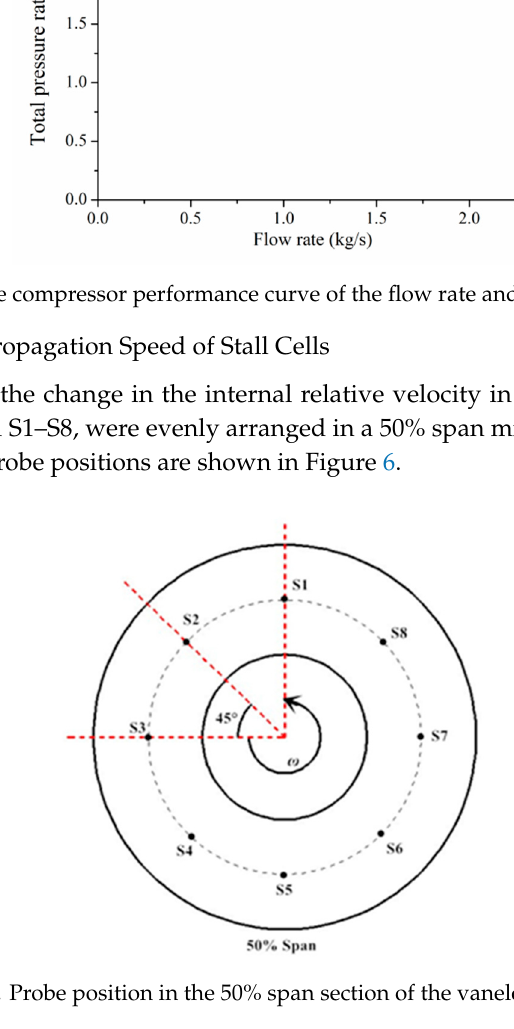
Figure 6. Probe position in the 50% span section of the vaneless diffuser.